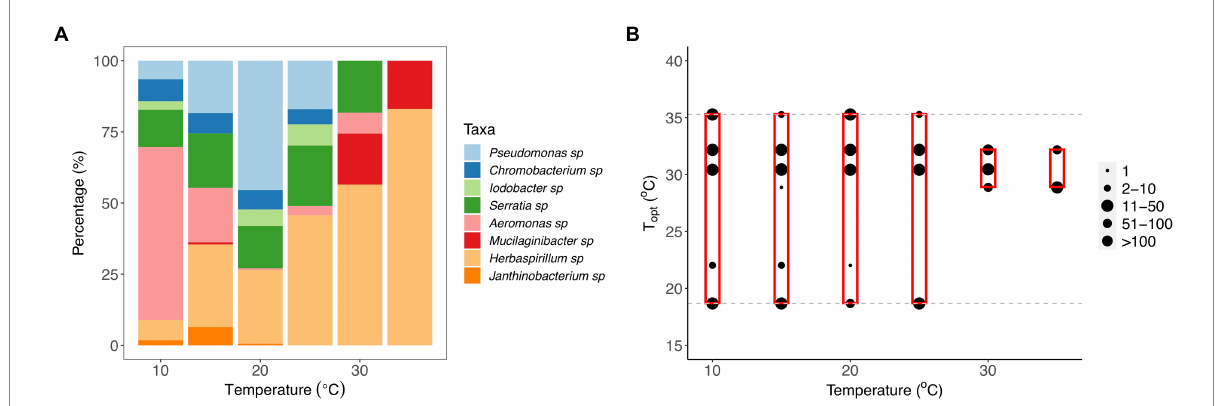
FIGURE 4 Changes in community composition with temperature. (A) Composition of bacterial taxa within communities incubated at 10, 15, 20, 25, 30, and 35 ° C for 7 days. Bar plot representing the percentage (%) of each taxon recovered in the samples at each temperature after the incubation period. (B) The composition of optimal growth temperatures for bacterial taxa within communities incubated at 10, 15, 20, 25, 30, and 35 ° C for 7 days. The gray dashed lines represent the optimal temperatures of bacterial taxa that were present in the original eight-taxa communities, and the red boxes represent the range of optimal temperatures of the taxa recovered within each temperature treatment at the end of the experiment. The size of the point represents the number of colonies of each taxon within the communities present on agar plates after